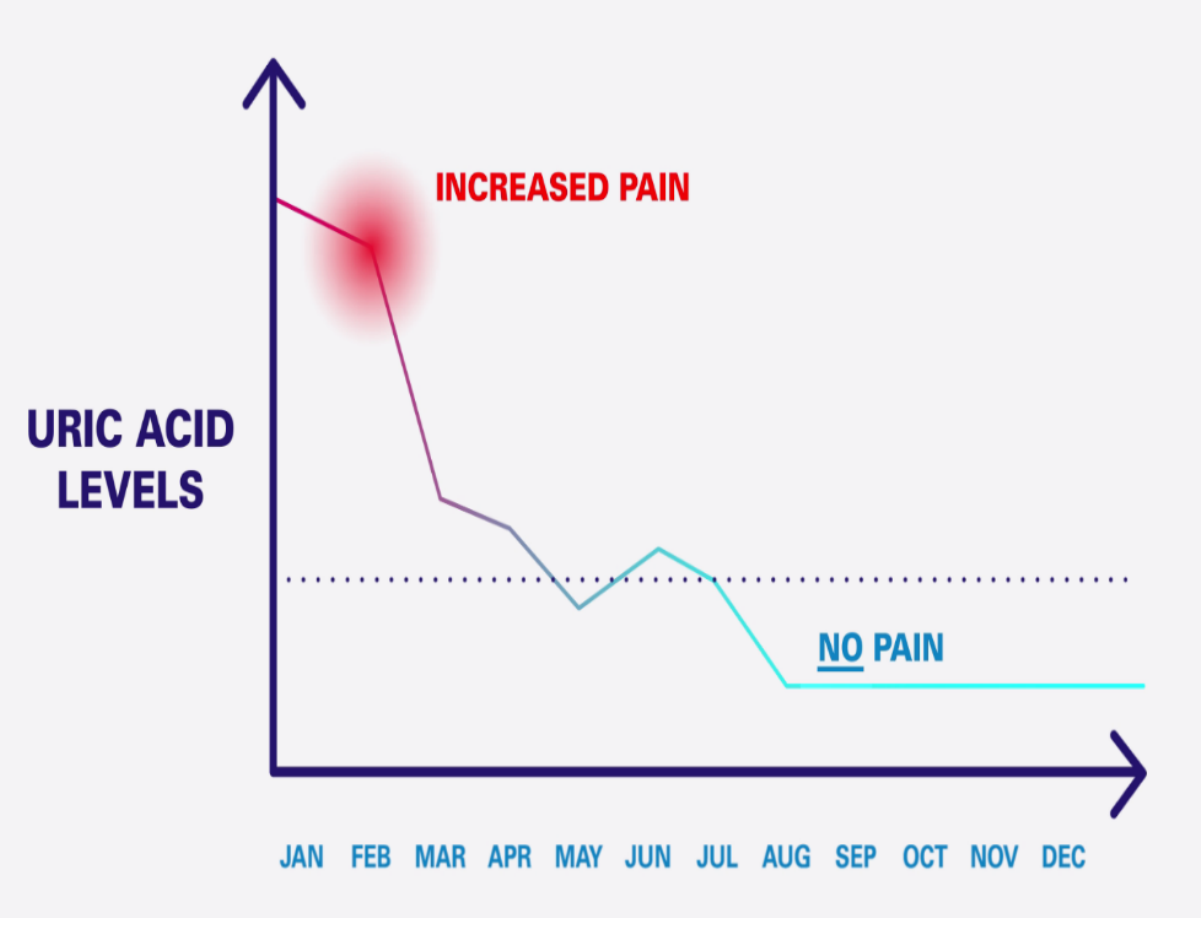
Figure 3. Graph of serum uric acid tracker shown in the educational animation